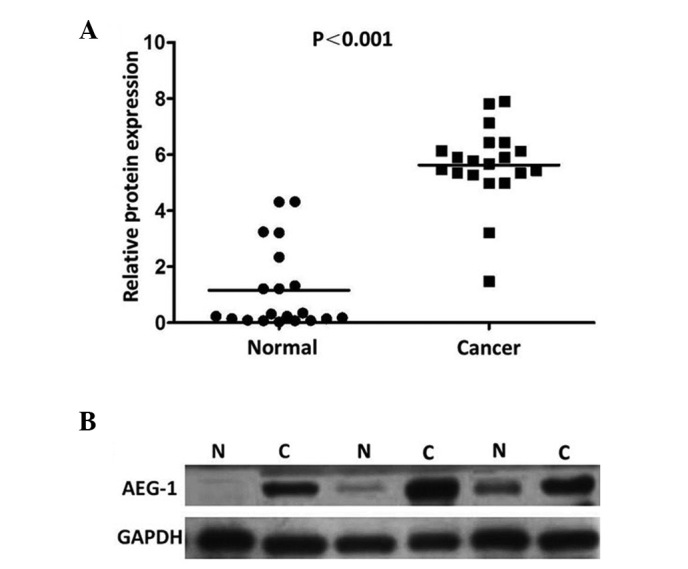
Increased protein expression of AEG-1 in GC as assessed by western blotting. (A) Relative AEG-1 protein expression levels in GC and non-cancerous tissues (AEG-1/GAPDH; n=20; P<0.001). Horizontal lines represents the mean. (B) Representative results of AEG-1 protein expression in three pairs of gastric tumor tissues and matched adjacent non-tumorous tissues. Lane N, matched non-cancerous gastric mucosa; Lane C, GC tissues; AEG-1, astrocyte elevated gene-1; GC, gastric cancer; GAPDH, glyceraldehyde-3-phosphate dehydrogenase.